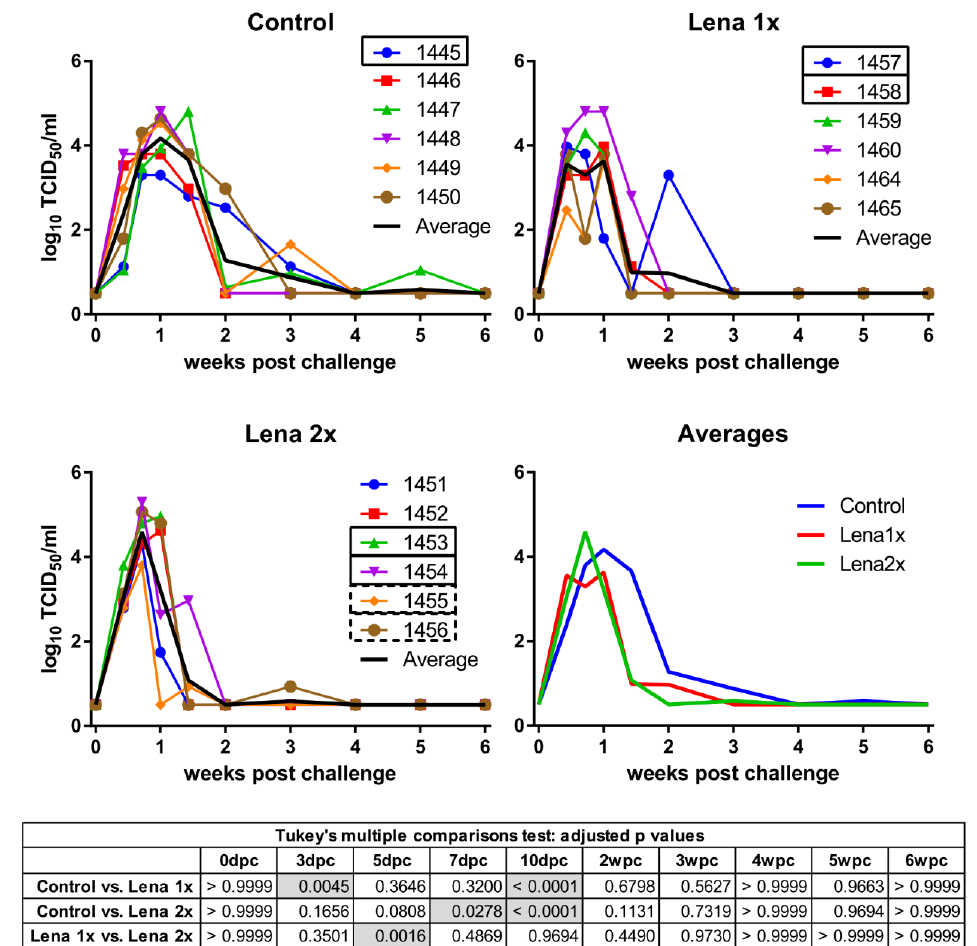
Figure 1. Viremia of Lena-vaccinated pigs following homologous challenge infection. Viremia was determined by titration on PAMs collected from porcine reproductive and respiratory syndrome virus (PRRSV)-negative pigs and IPMA. Pigs in the control group received two injections of PBS + adjuvant, eight and four weeks before the challenge. Group “Lena 1x” was vaccinated once with inactivated Lena, four weeks before the challenge. The group “Lena 2x” was vaccinated twice at eight and four weeks before the challenge. dpc—days post-challenge, wpc—weeks post-challenge. Numbers (1451–1465) represent the individual pigs. Solid rectangles around pig numbers mean they have been used in all ADE experiments, dashed rectangles mean that their sera have also been further analyzed, but not in all ADE experiments. The black line is the average of each group. Statistical analysis was performed with RM 2-way ANOVA, followed by Tukey’s multiple comparison test. Statistically significant values are highlighted in grey in the table under the